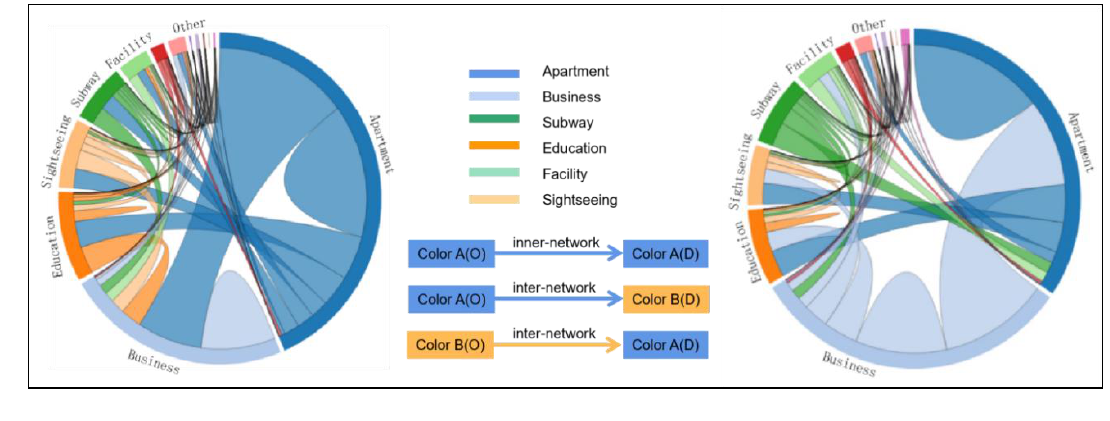
Figure 10. Network flow of taxi trips in Shenzhen City on weekdays.